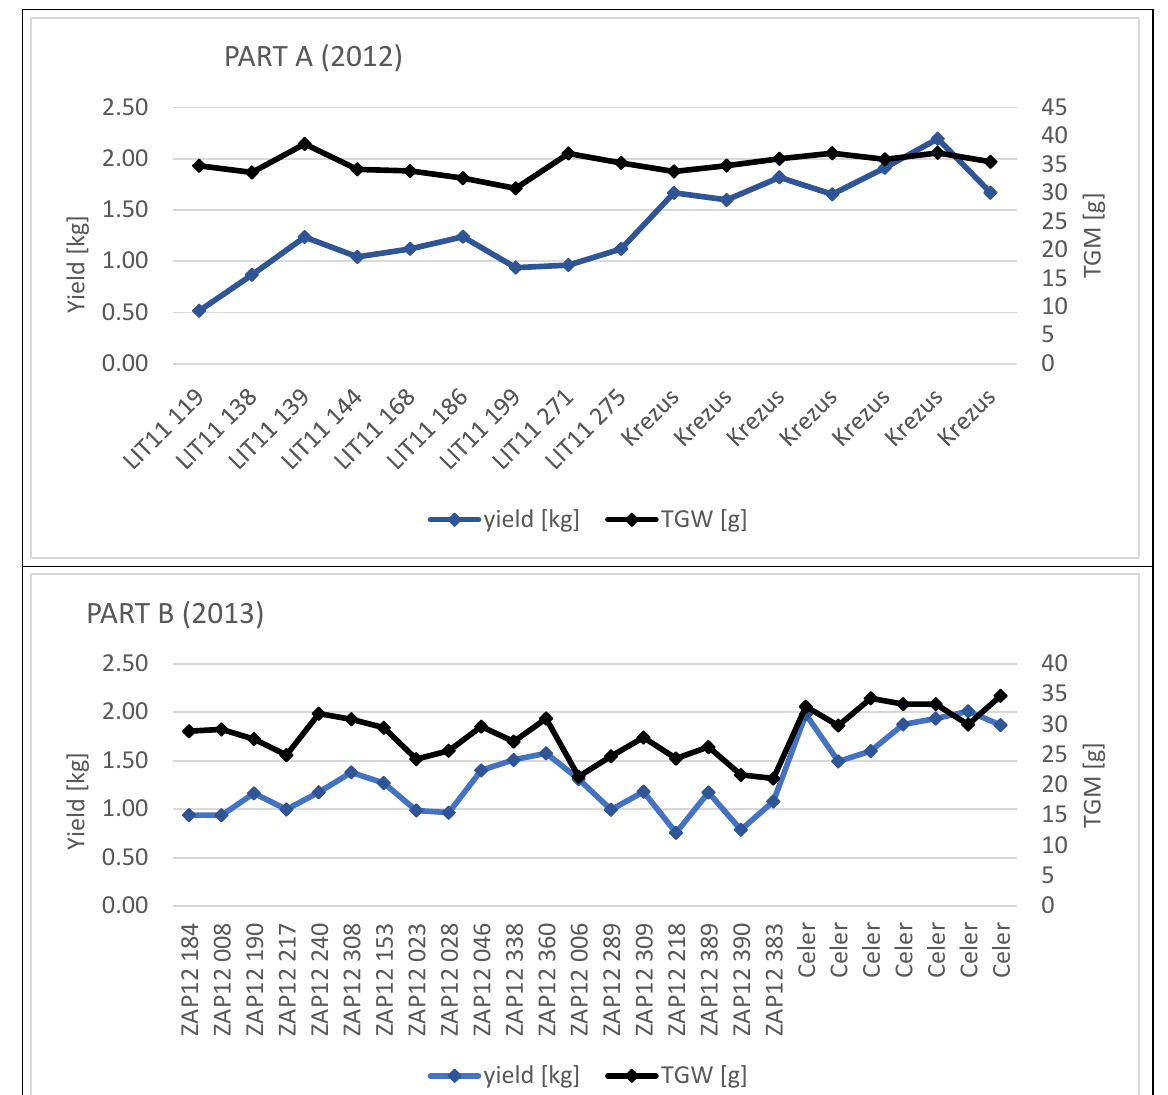
Figure 5. Yield parameters of Avena sativa L. accessions gathered in Lithuania and evaluated in 2012 and 2013 (modified from Kloc and Dostatny, 2020) [27].